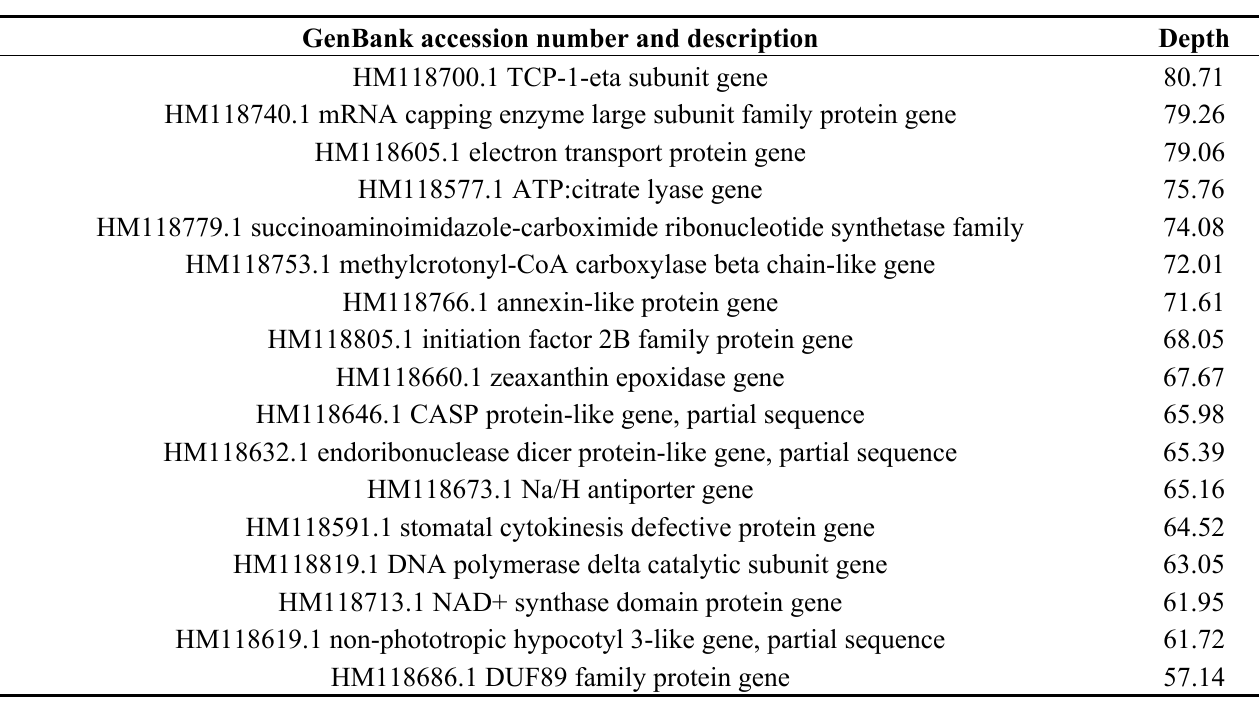
Table 1. Depths of coverage of previously published enset nuclear DNA sequences. The median depth of coverage is 67.67 times.